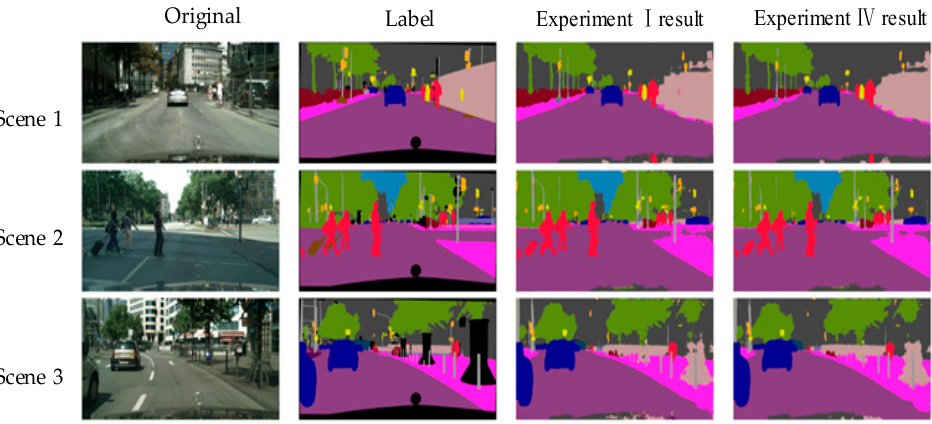
Figure 18. Images of Experiment I and Experiment IV on the Cityscapes dataset.